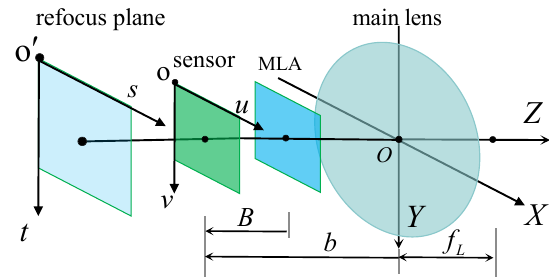
Figure 1. Illustration of coordinate